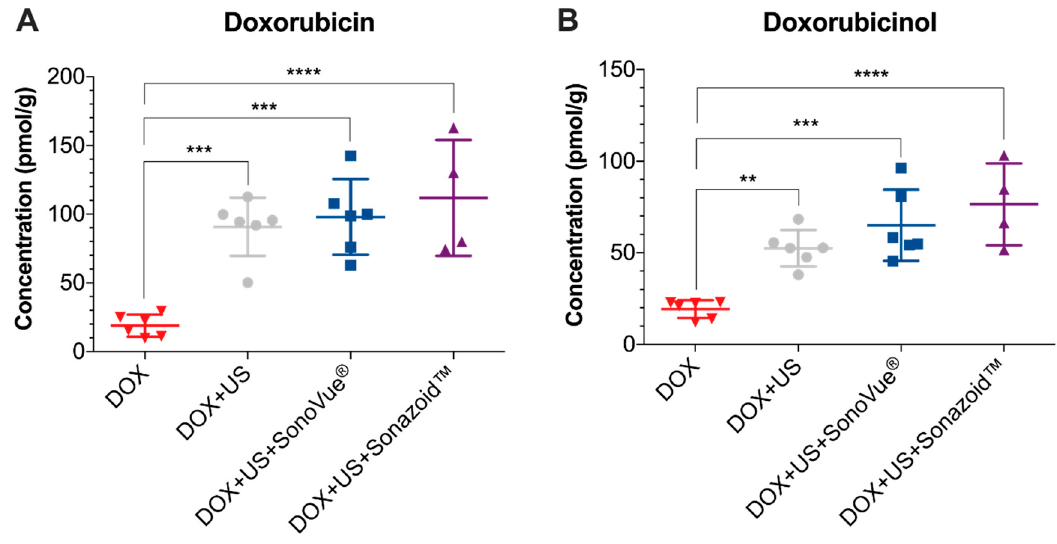
Figure 5. Concentrations (euthanasia day 9) of doxorubicin ( A ) and doxorubicinol ( B ). One-way ANOVA Dunnett’s multiple comparisons test with multiplicity adjusted p -values comparing the control group with all the treatment groups. ** p -value < 0.01, *** p -value < 0.001, and **** p -value < 0.0001.